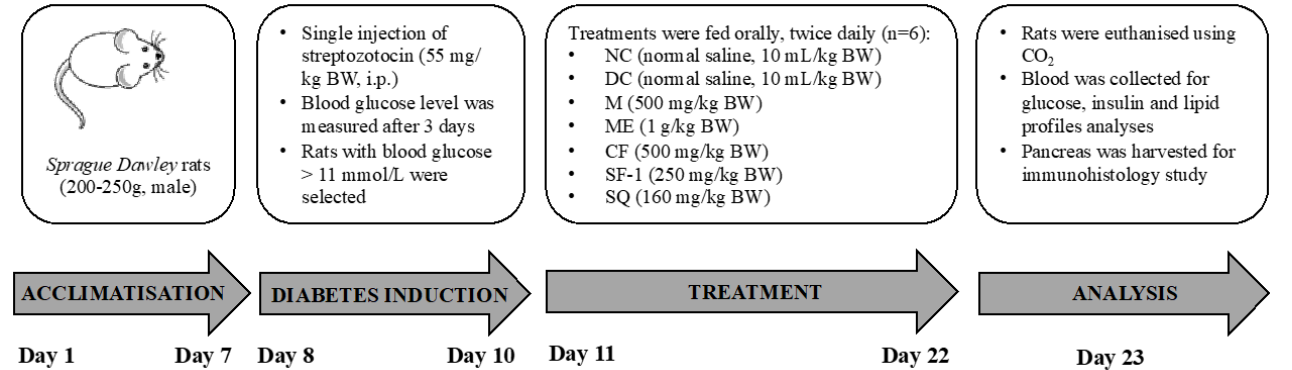
Figure 10. In vivo antihyperglycemic test.